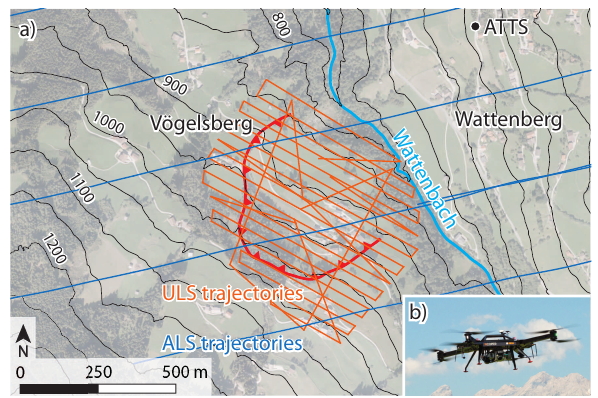
Figure 2. Setup of the landslide monitoring. ULS flight trajectories (orange) and ALS trajectories (blue) over the active part of the V¨ogelsberg landslide (red) (a) and the RIEGL RiCOPTER equipped with a VUX-1lR laser scanner (b). The location of the automatic tracking total station (ATTS) is shown in (a). Figure 1. Location of the V¨ogelsberg landslide in the province of Tyrol, Austria.